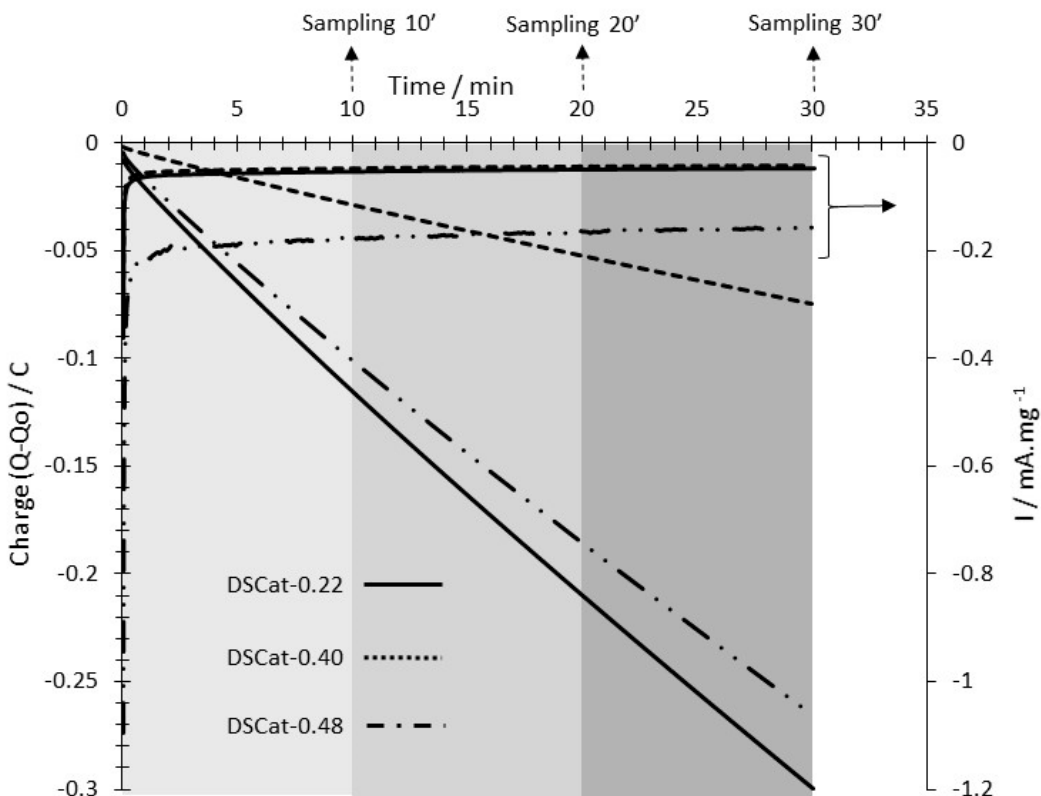
Figure 7. Oxygen Reduction Reaction (ORR) chronoamperometry recorded on DSCat-0.22, 0.40, and 0.48 in HClO 4 0.1 M for ORR selectivity measurement. Both the charge in coulomb and the current expressed in mA per mg of catalysts in the porous electrode are reported as a function of time. Grey areas picture the 10 min time windows after which the electrolyte sampling was performed.